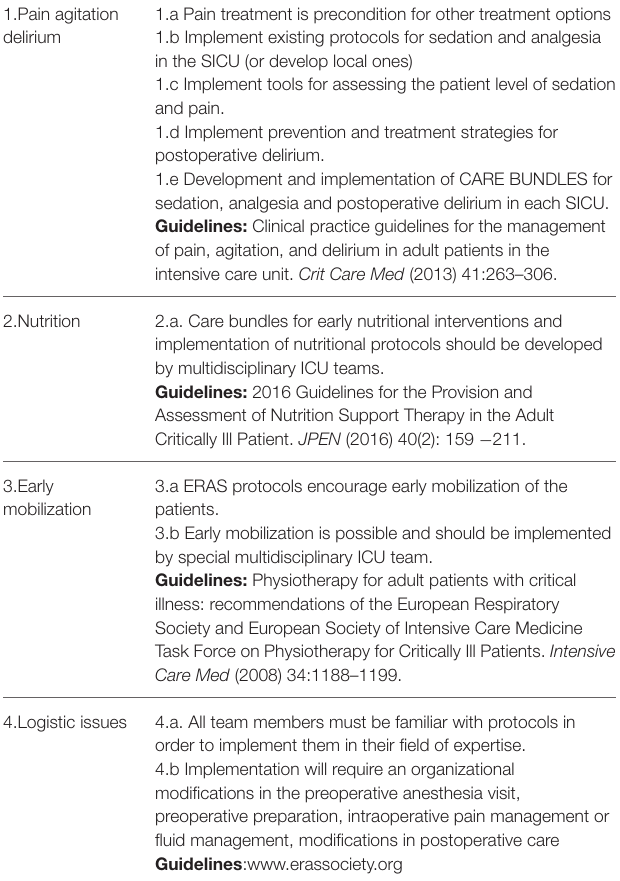
TABLE 1 | Summary of recommendations for ERAS in